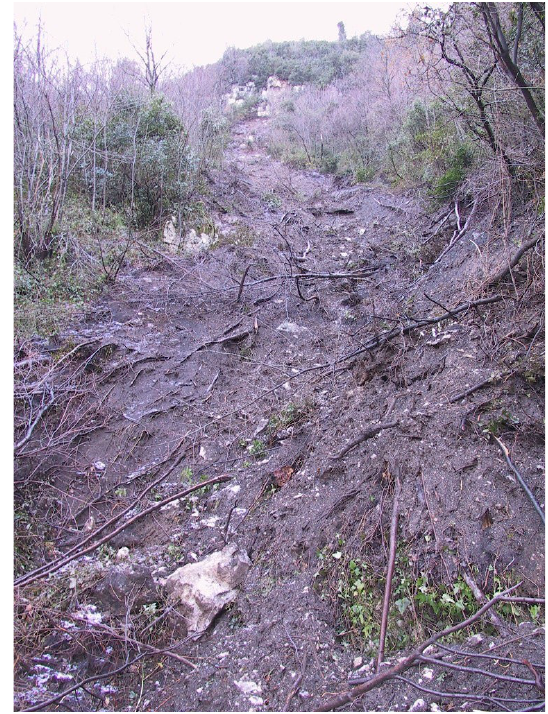
Fig. 4. View of the debris flow triggered by the rockfall on 10 Jan- uary